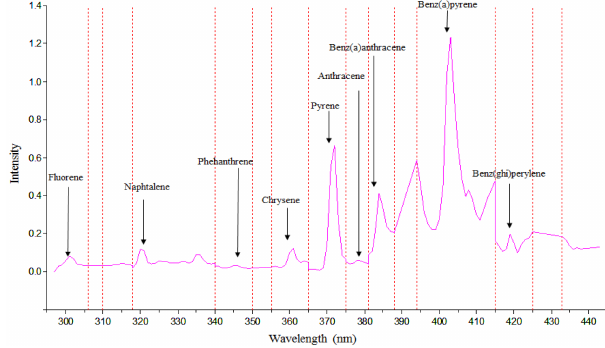
Figure 5. PAH luminescence spectra for SRM NIST